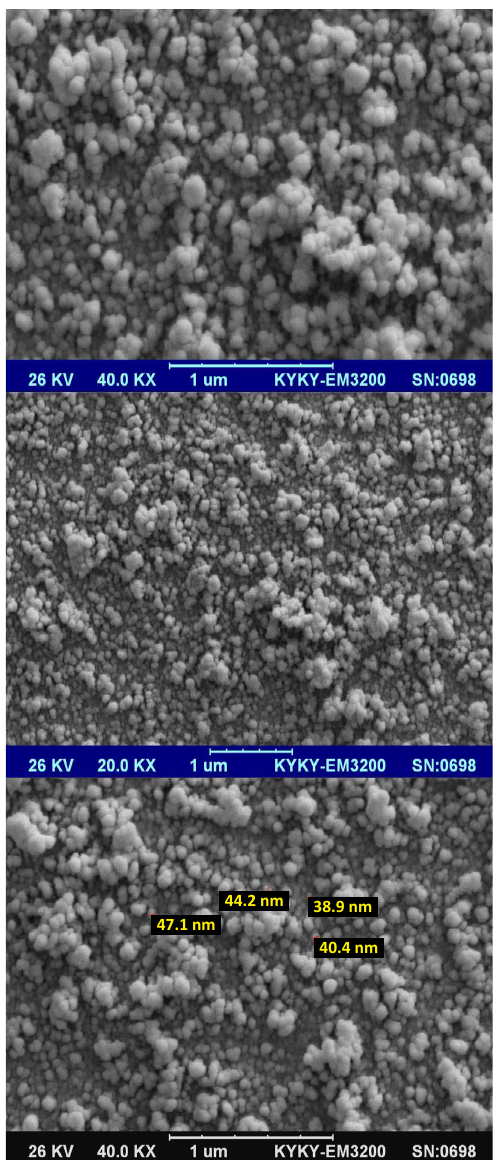
Fig. 2. SEM images of CuFe